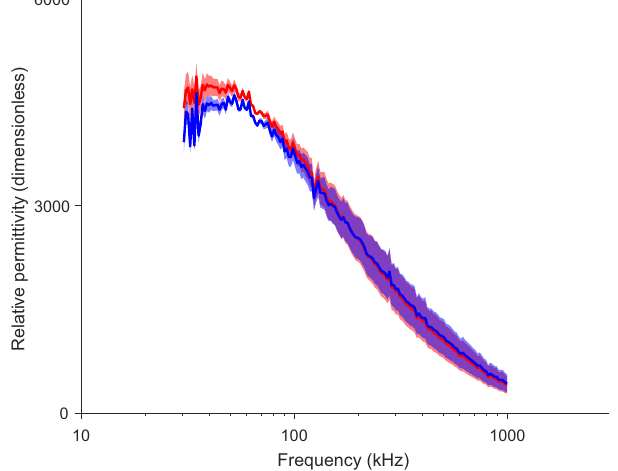
Figure 9. Estimated relative permittivity in longitudinal (blue) and transverse (red) direction. In situ mean ± standard deviation ( M = 3 measurements).